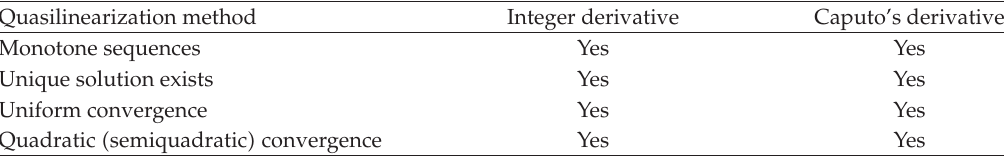
Quasilinearization